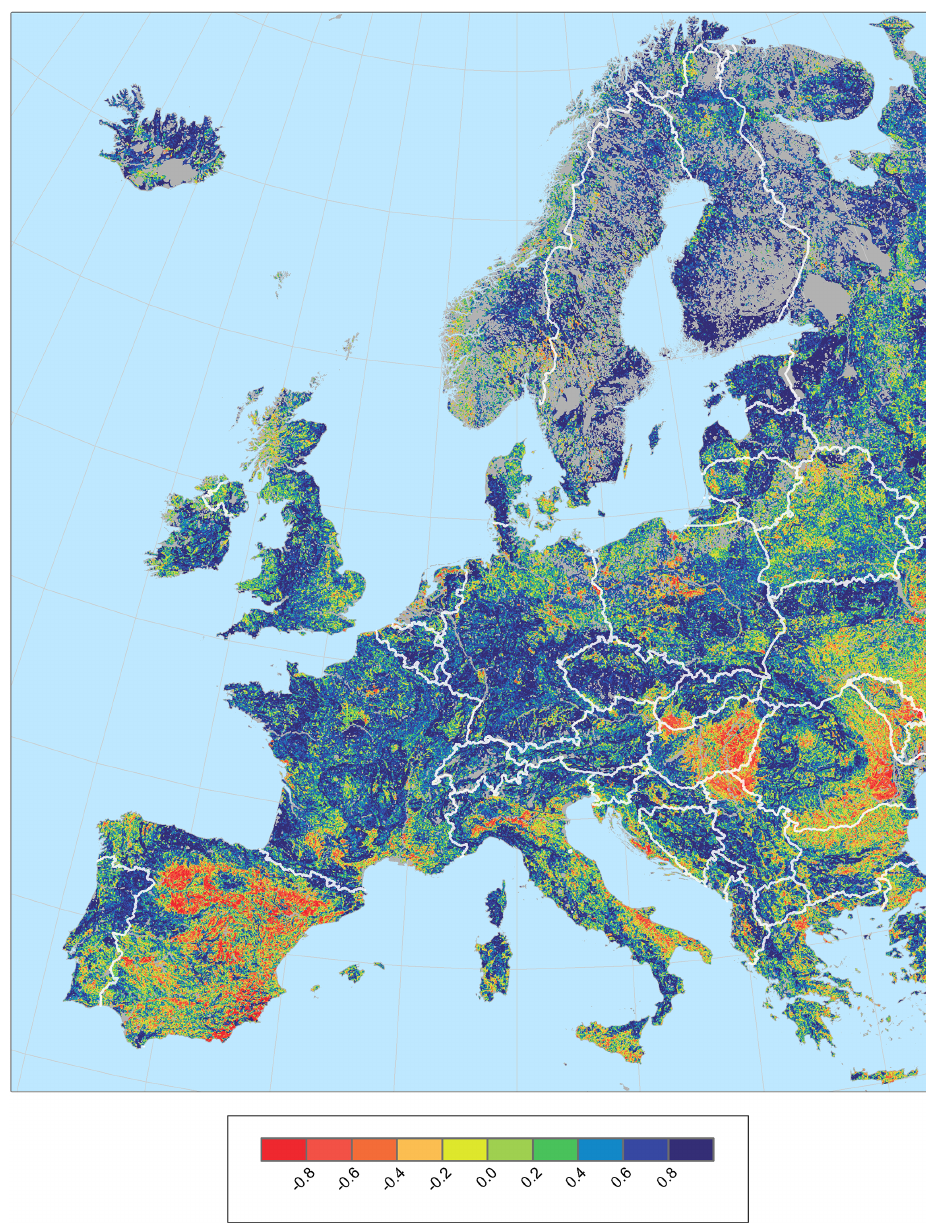
Figure 6. Spatial correlation between the models computed for groundwater pH and Ca 2 + . Values show the Pearson correlation coefficient computed over every single cell by using a sampling of 25 neighbouring cells. The map was created entirely by the authors with state borders from ArcGIS® version 10.2 (Esri, Redlands, CA,